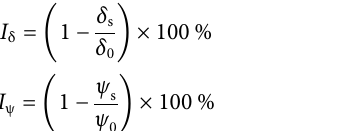
Frontiers in Materials |